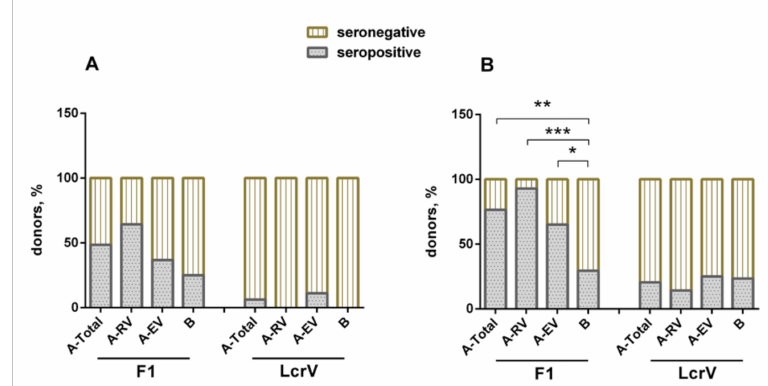
Figure 3. Detection of antigen-specific antibodies to F1 and LcrV in sera obtained from vaccinees (groups A-Total, A-RV, A-EV) and naïve donors (group B) using ( A ) ELISA and ( B ) the immunoblot technique. Fisher’s exact test was used for analysis of di ff erence between groups; * p < 0.05, ** p < 0.01, *** p <